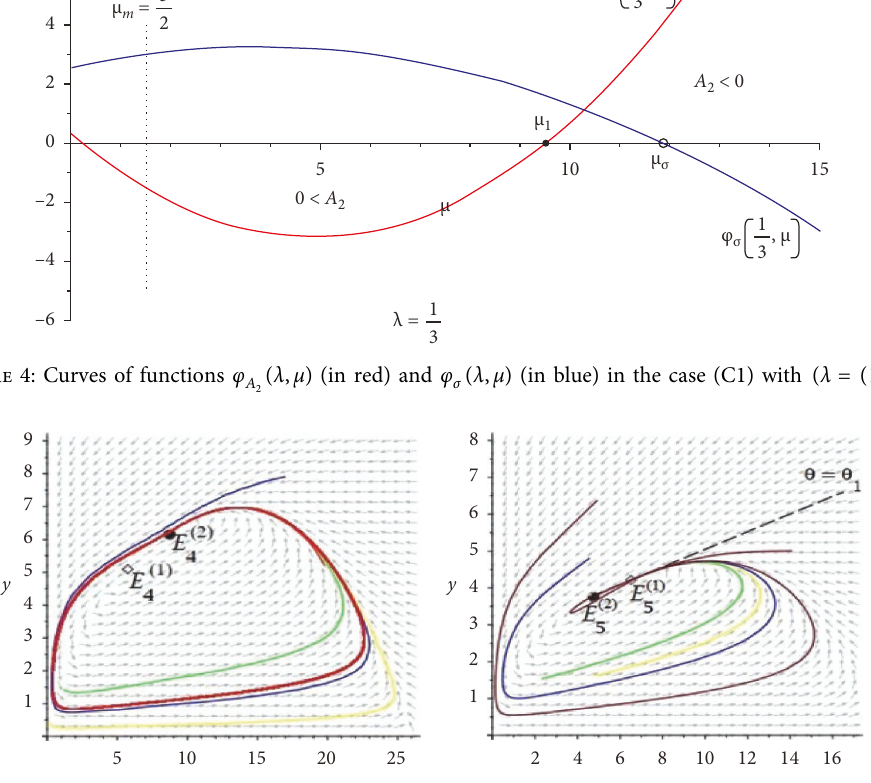
of codimension 2 and an unstable node E ( 1 ) 4